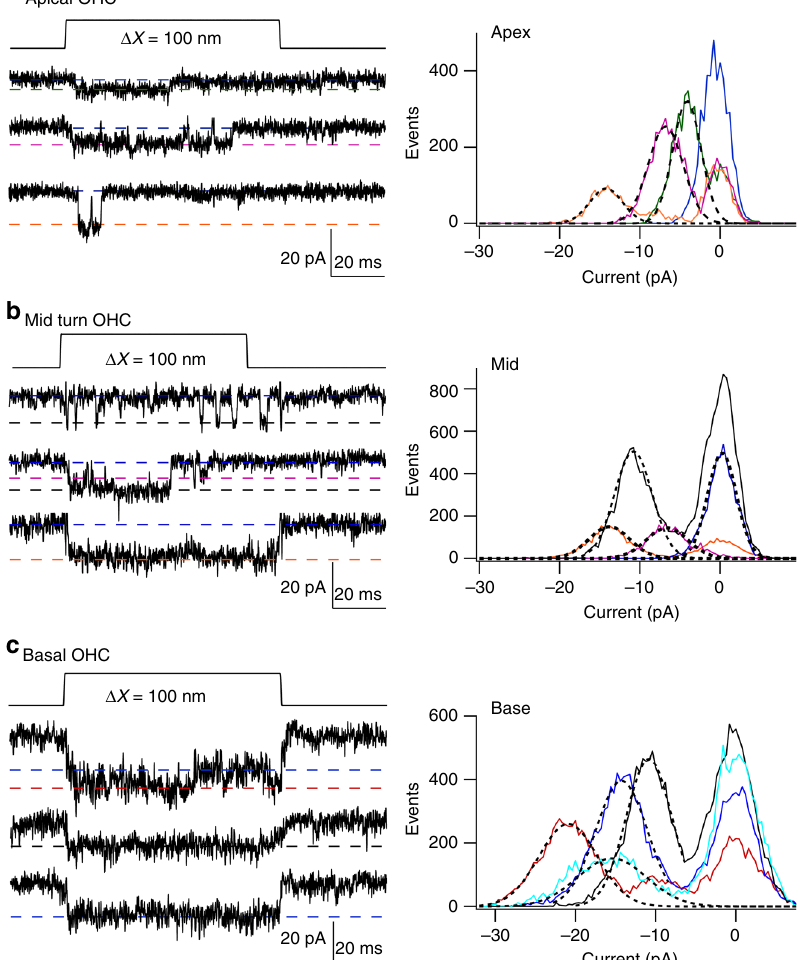
Fig. 5 Histograms of multiple-level channel events. a Apical OHC, three traces of channel responses to 100 nm step de fl ection of the hair bundle, with peak levels (corresponding to x o values) drawn as dashed lines. Histograms of amplitude distributions of segments of these and three other traces, with different levels, fi t with Gaussians = A exp{ − ( x − x o) 2 /2 σ 2 } (black dotted lines superimposed on noisy data) with values of x o and σ : − 4.1, 1.7 pA; − 6.7, 2.2 pA; − 14.2, 2.1 pA. b Middle turn OHC, three traces. Gaussian fi ts with values of x o and σ : − 6.6, 3.7 pA; − 10.8, 3.3 pA; − 13.8, 3.6 pA. For the brief openings, exempli fi ed in top trace, fi ve histograms were summed to produce the green curve. c Basal turn OHC, three traces, and Gaussian fi ts with values of x o and σ : − 10.8, 2.8 pA; − 14.2, 3.6 pA; − 15.4, 4.2 pA; − 20.9, 3.6 pA. holding potential − 84 mV. For all locations, each amplitude histogram (color) represents the sum of multiple analyses. The analyses in ( b ) and ( c ) are from the same pool of data as in Fig. 4c, d